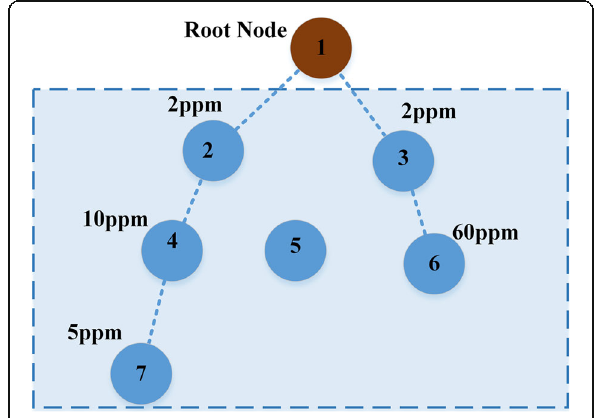
Fig. 2 Illustrating the load imbalance problem due to heterogeneous traffic rate Fig. 3 The Contiki OS network stack for a sensor